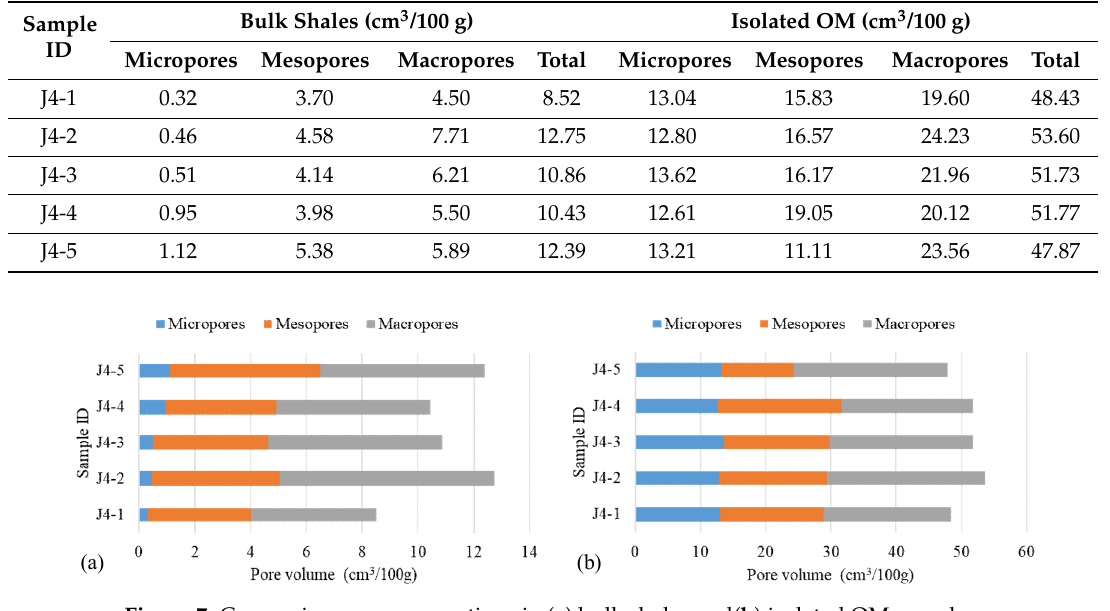
Figure 7. Comparison pore proportions in ( a ) bulk shales and( b ) isolated OM samples.